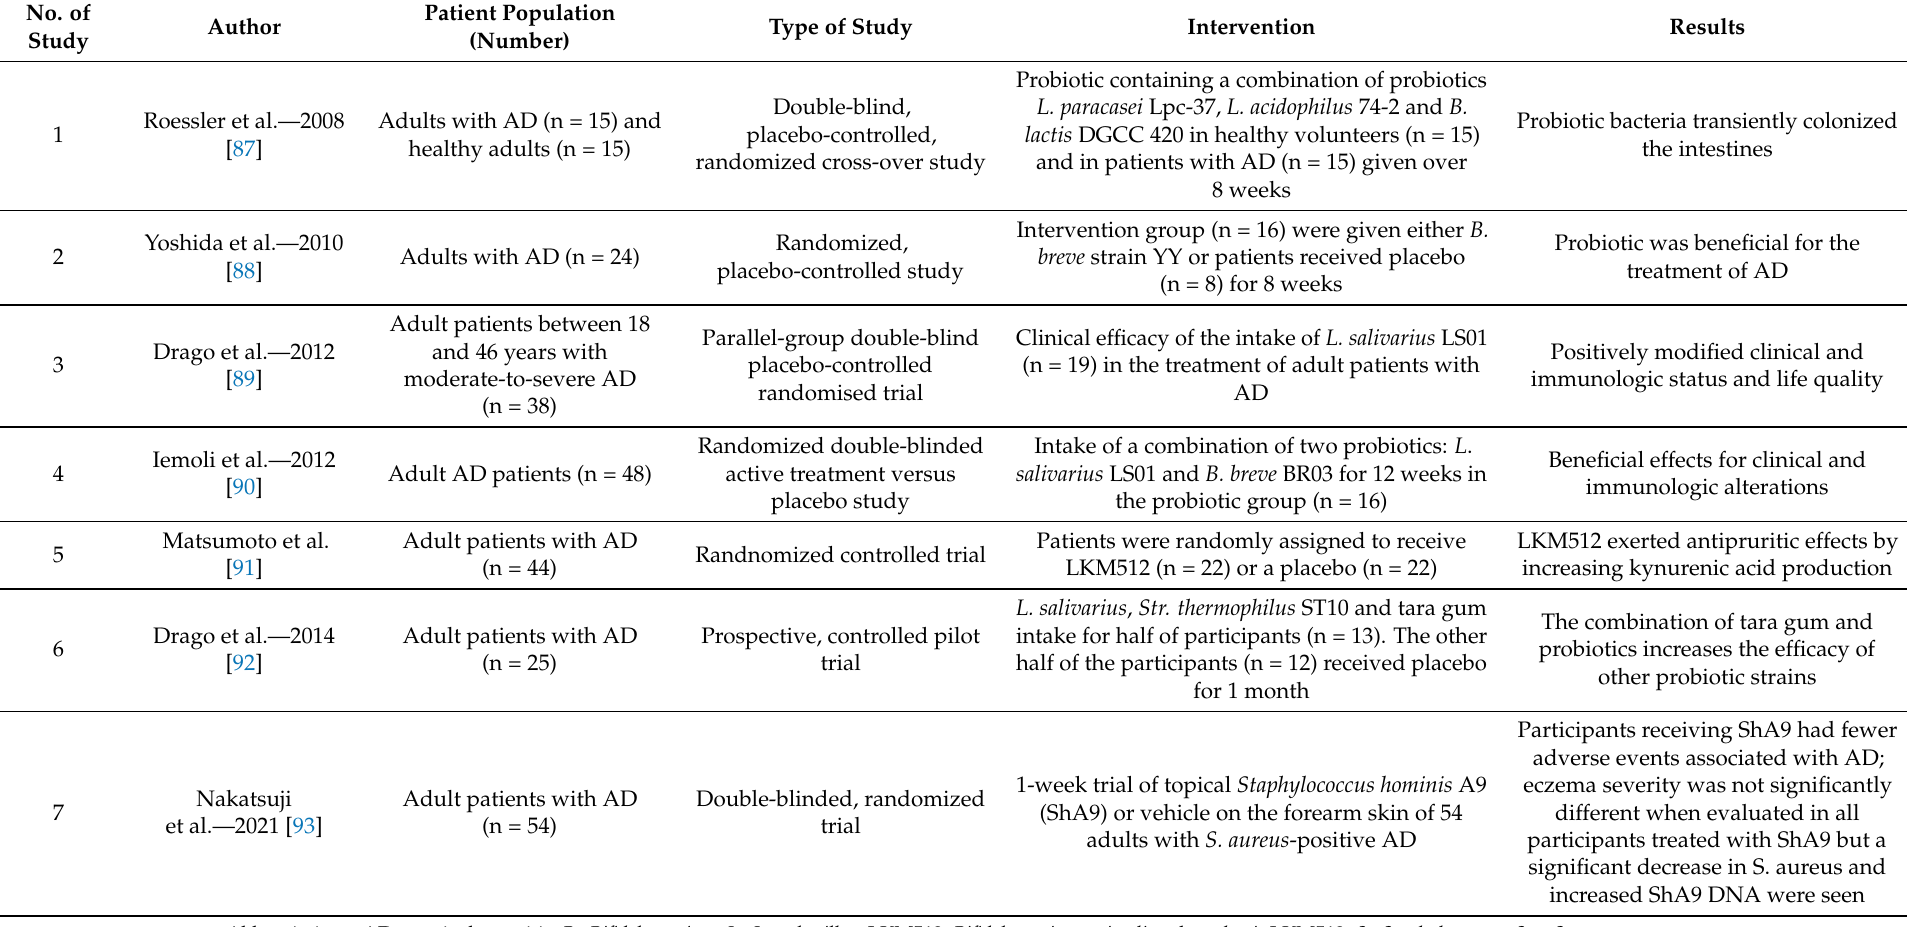
Table 5. Pre- and probiotics in the treatment of AD in